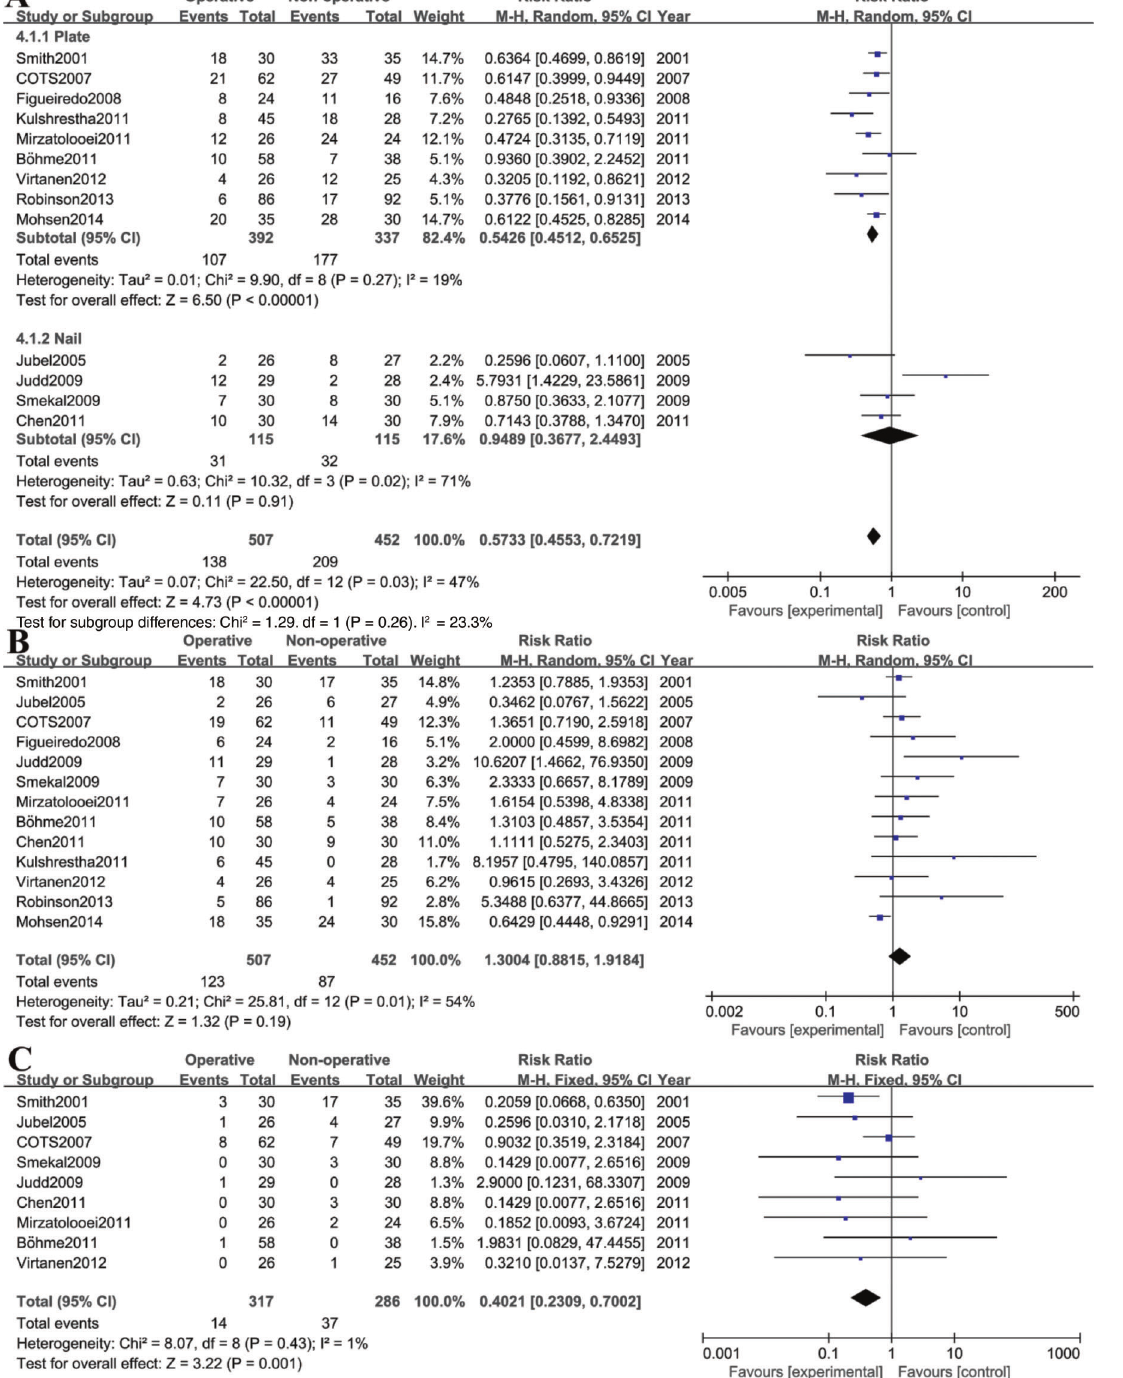
Figure 4 - Forest plot showing comparison of complications rates (A and B) and neurologic symptoms rates (C) between operative (experimental) and nonoperative (control)